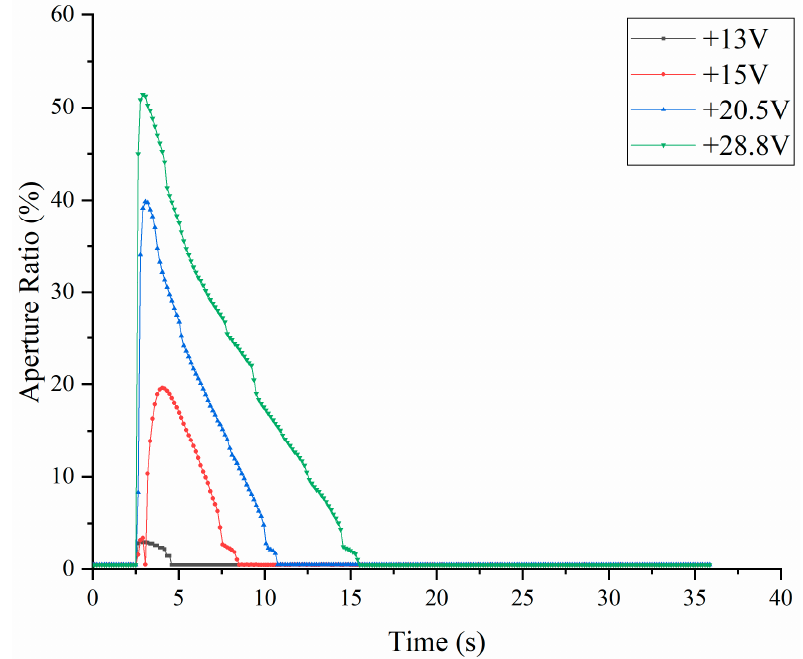
Figure 6. Aperture ratio with a DC